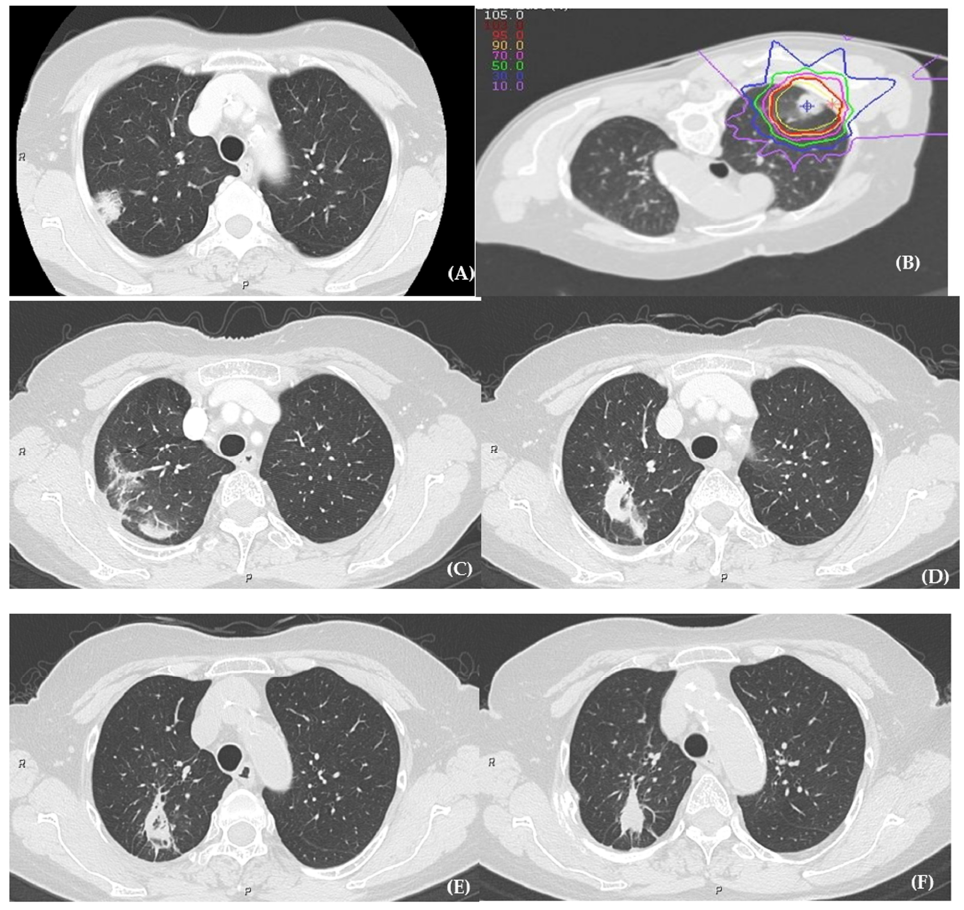
Figure 1. The course of grade 1 radiation pneumonitis after carbon-ion radiotherapy. ( A ) The pretreatment lung tumor. ( B ) The treatment plan for the patient. The patient received carbon-ion radiotherapy in prone position with four ports. ( C ) The lung image 6 months after treatment. The infiltration shadow is spread around the irradiated area of the lung. ( D ) The lung image 1 year after treatment. The infiltration shadow gradually shrunk. ( E ) The lung image 3 years after treatment. ( F ) The lung image 7 years after treatment. The infiltration shadow shrunk, and there is no evidence of local recurrence.